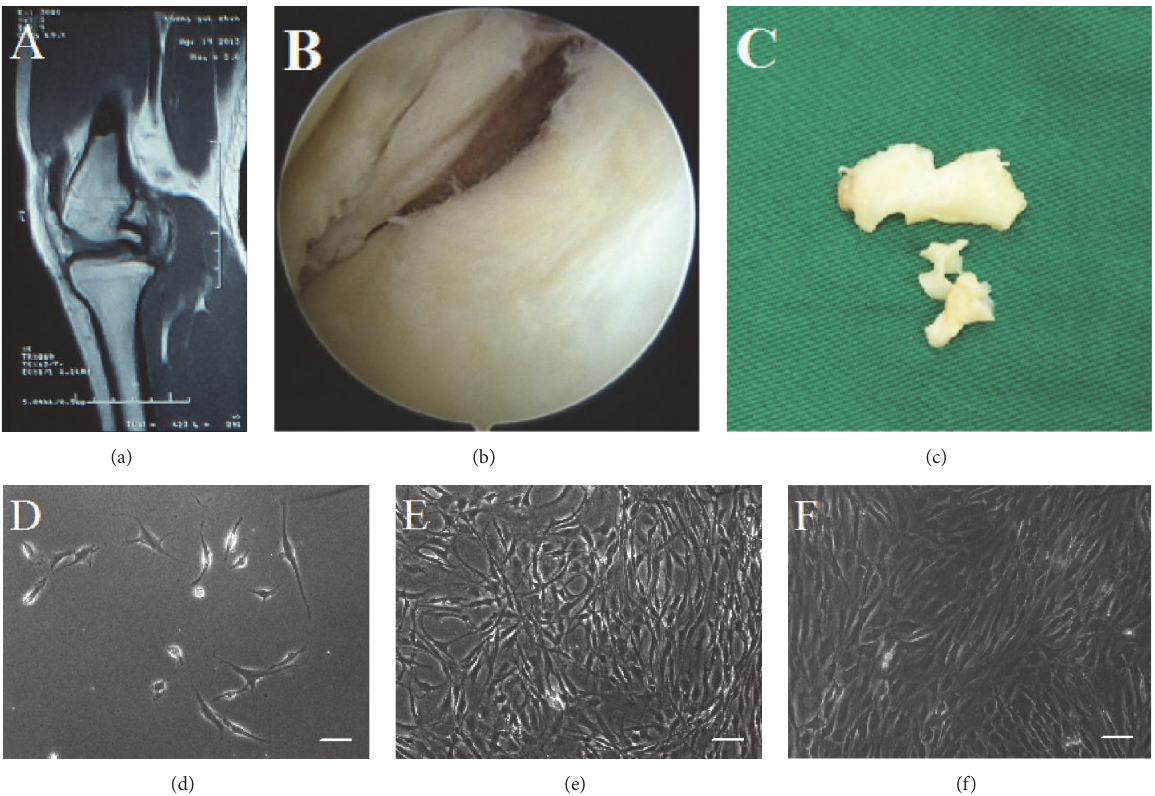
Figure 1: Magnetic resonance imaging (a) showing a typical bucket-handle tear of medial meniscus in sagittal view and arthroscopic examination (b) of patients with meniscal tears. Meniscal debris (c) was obtained during surgery. At 3 ∼ 5 d after plating, some cells were observed to adhere to the culture dish (d). Cells took on a swirling or cluster appearance by 10–12 d (e), and they remained homogeneous until the third passage (f). Scale bar = 100 𝜇